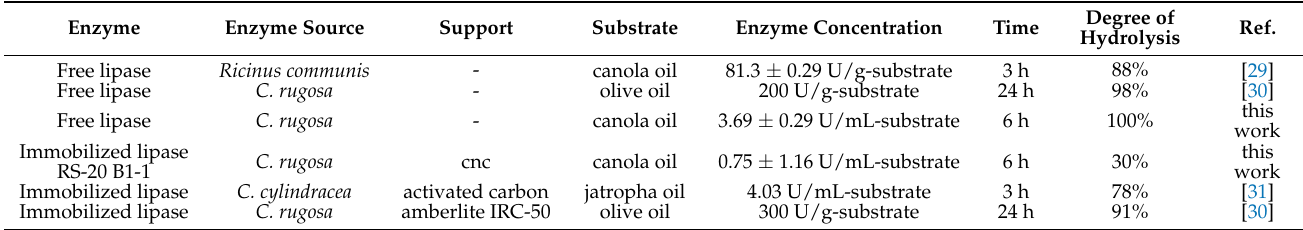
Table 4. Comparison with the previous studies.